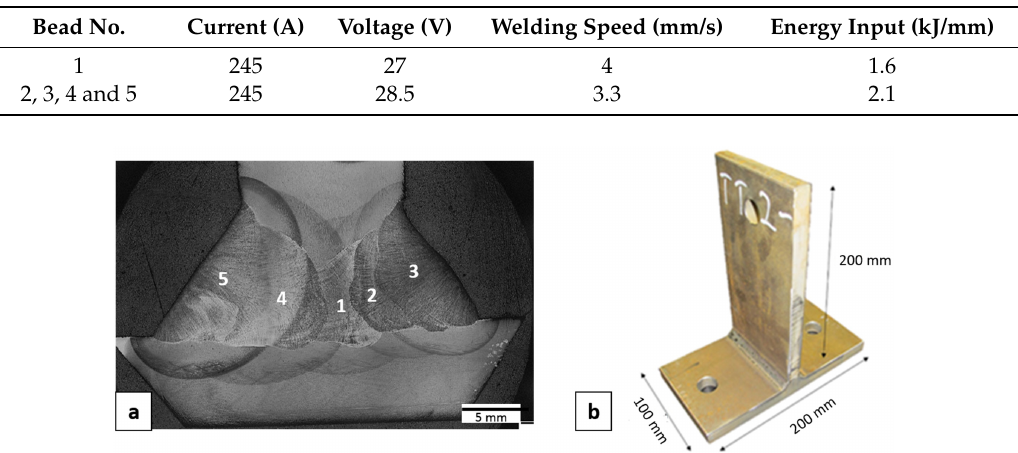
Table 3. Welding parameters.